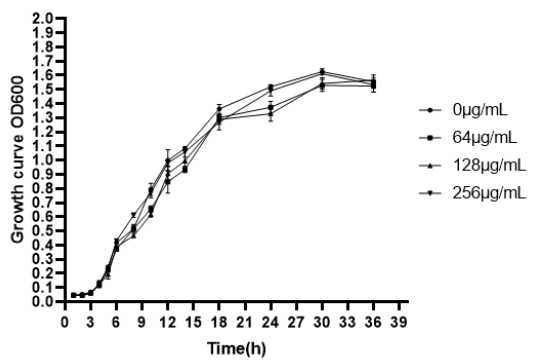
Figure 2. Effect of EGCG on the growth of P. aeruginosa . (All data are representative of three independent experiments performed in triplicate and expressed as the mean ± SD values in each bar.